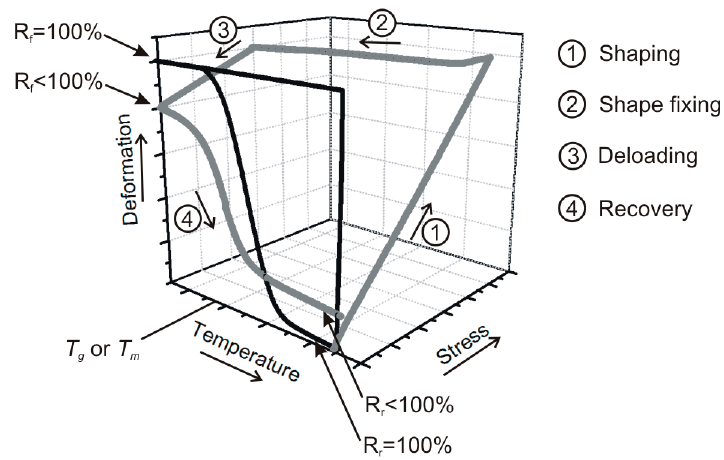
Figure 1. Single SM cycles of a 1W-SM polymer (black) and its composite (grey), schematically.